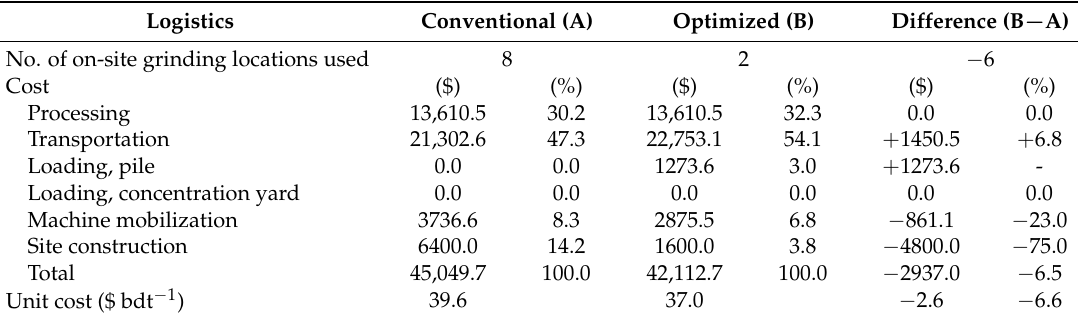
Table 5. Results of a cost analysis for conventional and optimized